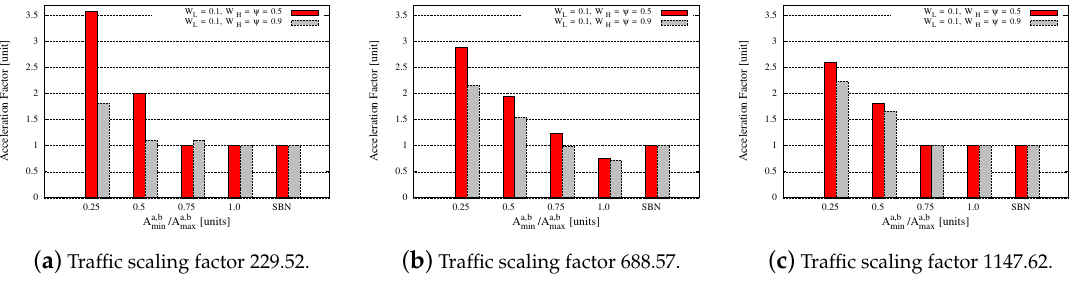
Figure 8. AF avg with AF sleep = 0.5 units and χ = 0.5 h/cycle after 14 days vs. the ratio A a , b fixed total load.